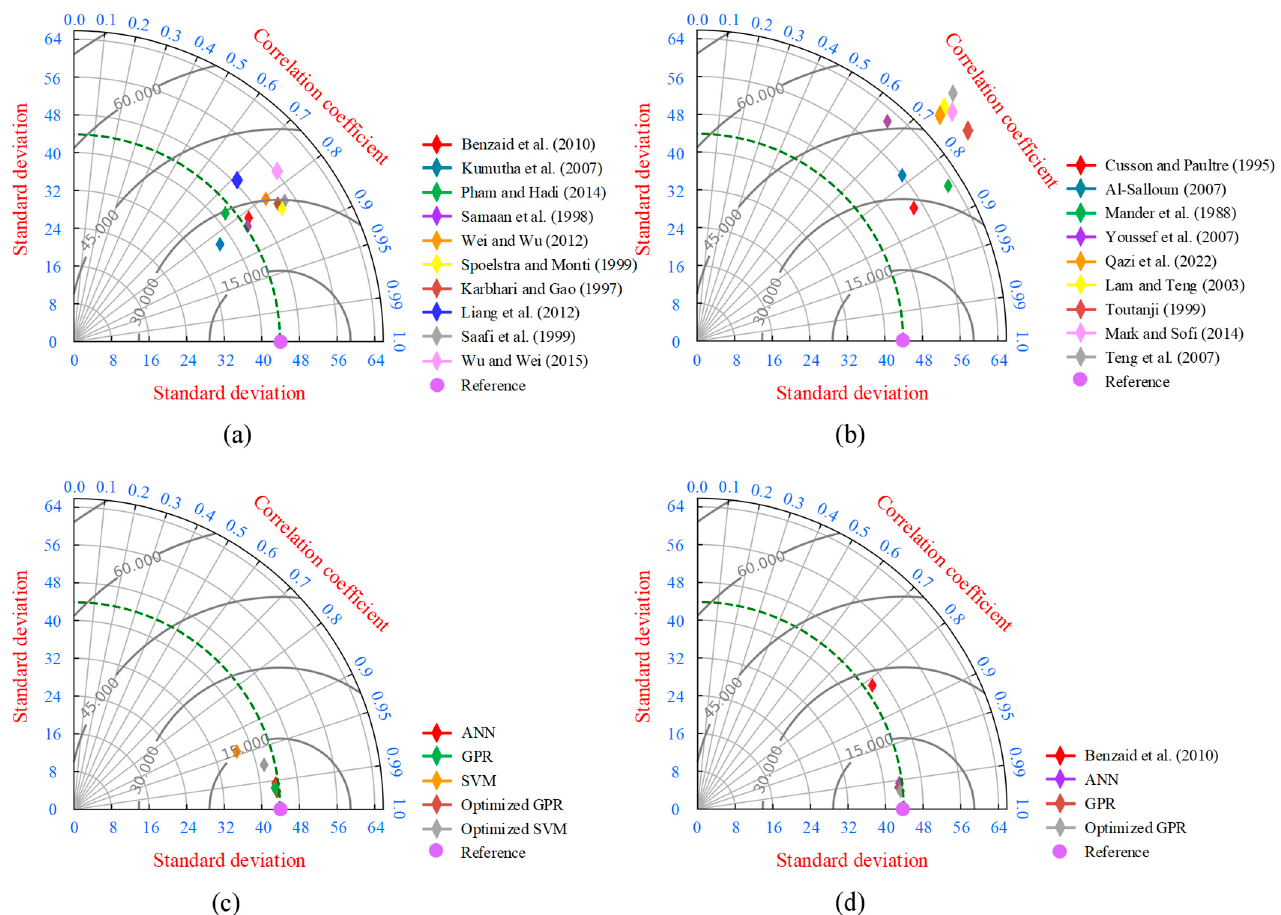
Figure 13. Violin with box plot and frequency distribution of errors.